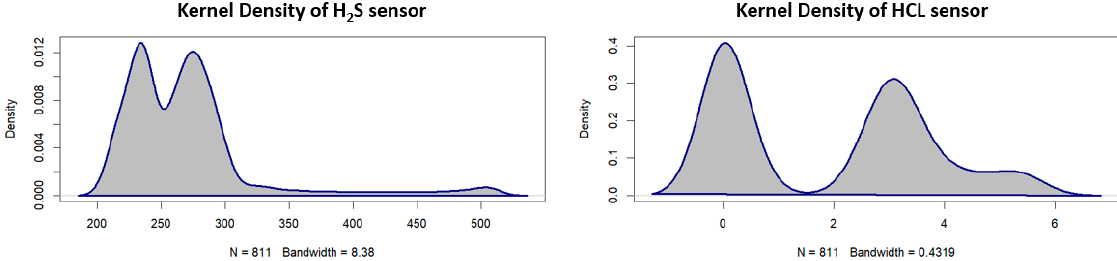
Figure A5. Kernel density for first second measurement (PM 1.0 sensor, PM 2.5 sensor, PM 10 sensor, C X H Y sensor).